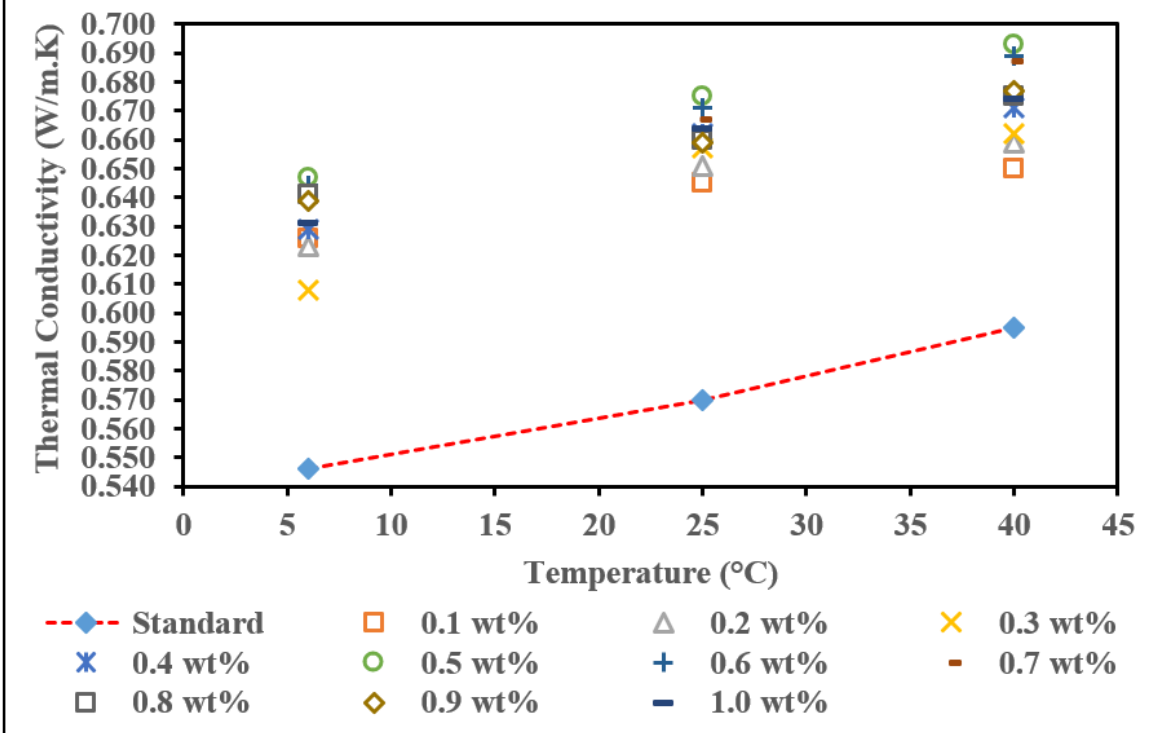
Figure 11. Thermal conductivity of base fluid containing surface oxidized MWCNTs with PVP with various concentrations at different temperatures. Table 7. Thermal conductivity enhancement of surface oxidized MWCNTs nanofluid without PVP. Weight Concentration of Surface Oxidized MWCNTs